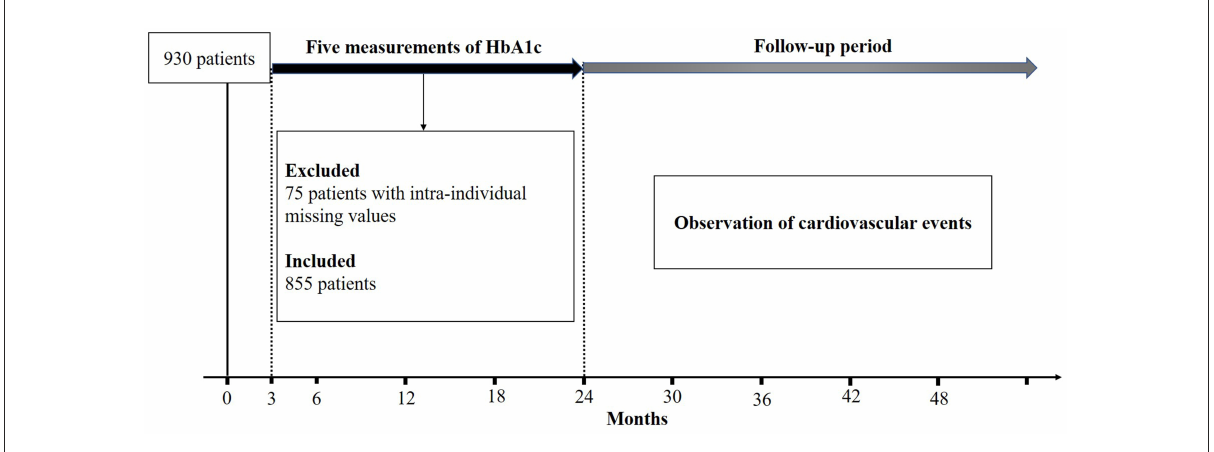
FIGURE1 Experimental design in the intensive glucose control.